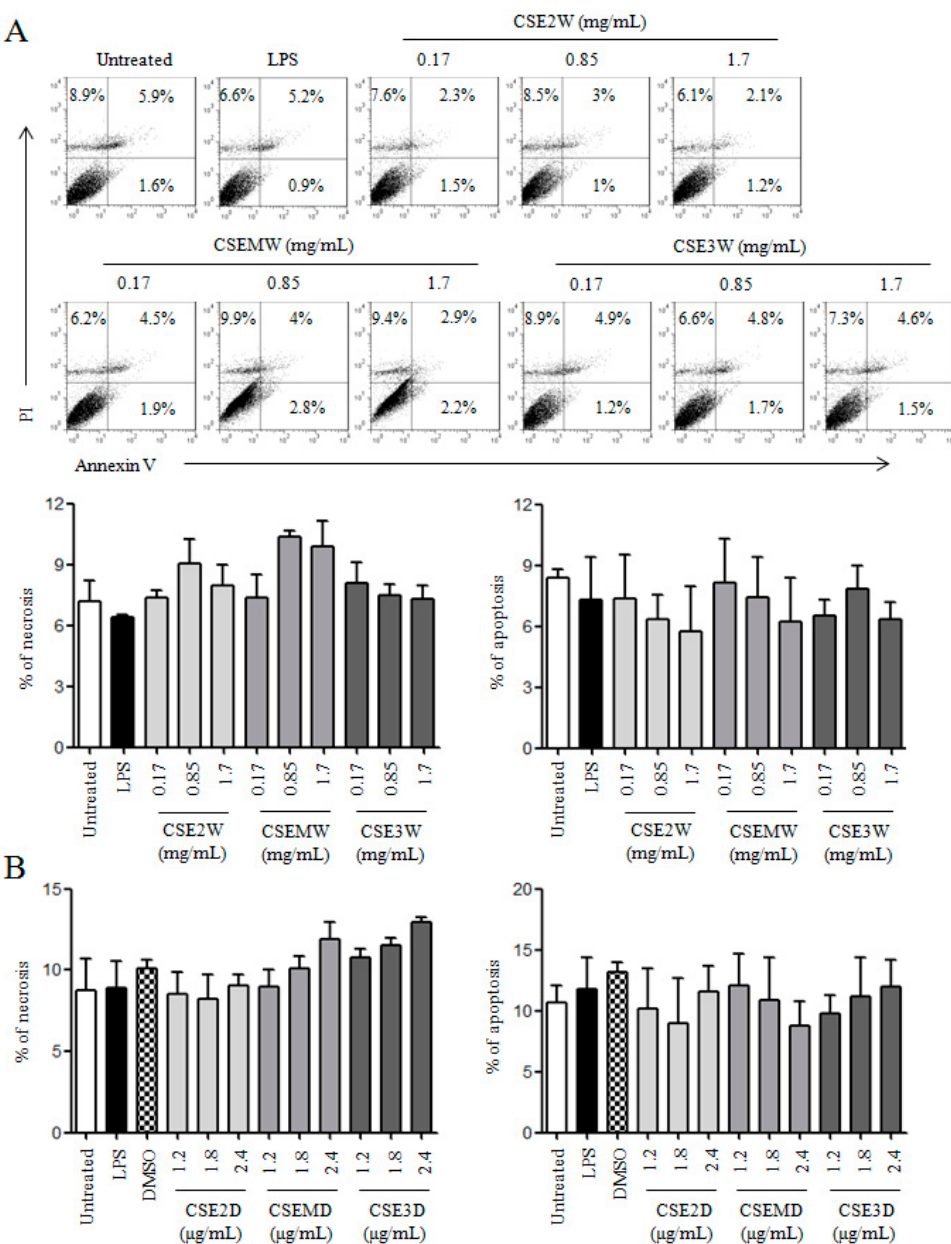
Figure 2. The effect of CSEs on DC viability. Mouse bone marrow-derived DCs were treated with different concentrations of polysaccharides in CSE2W, CSEMW, and CSE3W ( A ) or flavonoids in CSE2D, CSEMD, and CSE3D ( B ). After 12 h, cells were collected and stained with Annexin V/PI kit. The representative dot plots are shown in upper panels. The summary of necrotic and apoptotic DCs are shown in lower panels.